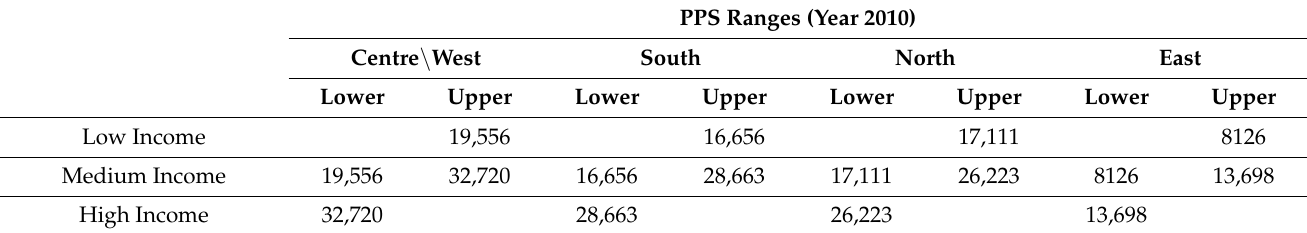
Table 2. PPS ranges of the differentiated income classes in regions in the EU. PPS Ranges (Year 2010) Centre \ West South North East Lower Upper Lower Upper Lower Upper Lower